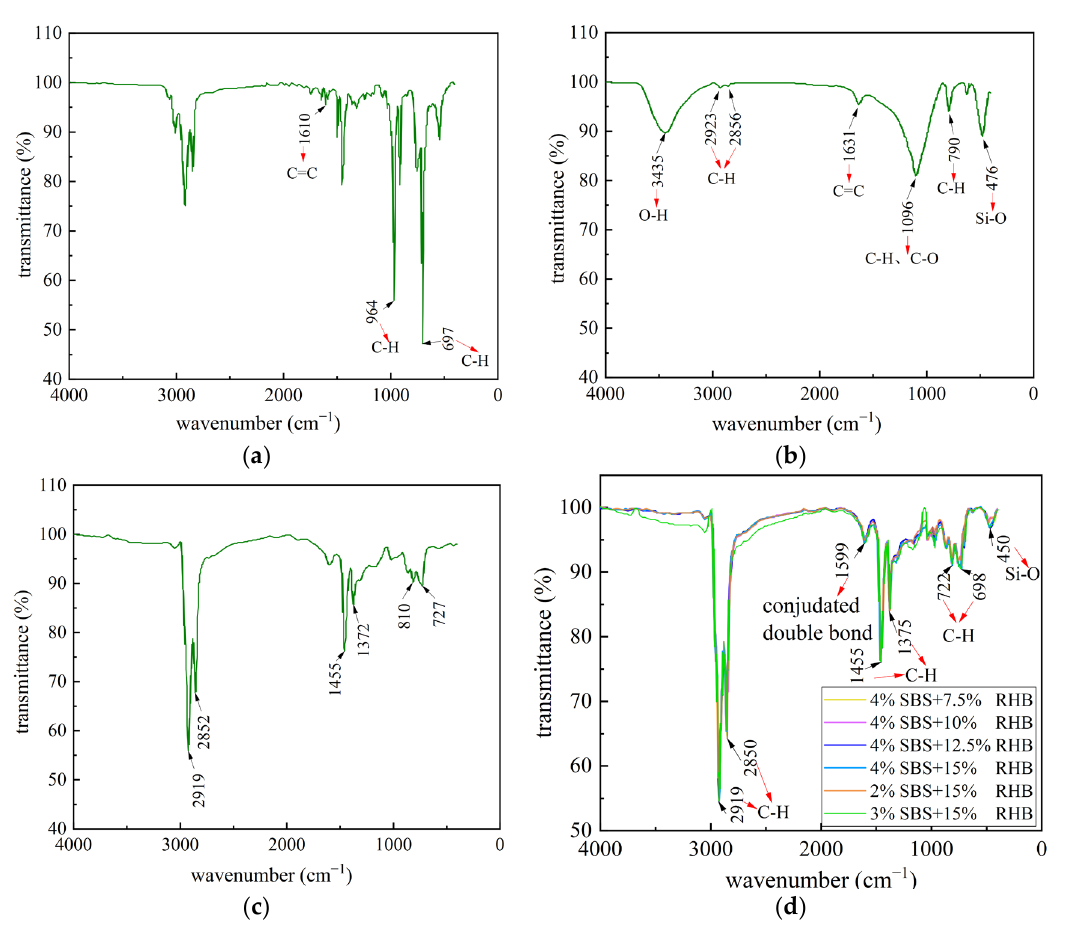
Figure 11. FTIR spectra of modifier and composite-modified asphalt. ( a ) SBS, ( b ) RHB, ( c ) base asphalt, ( d ) comparison of FTIR spectra of composite-modified asphalts with different RHB-SBS contents.